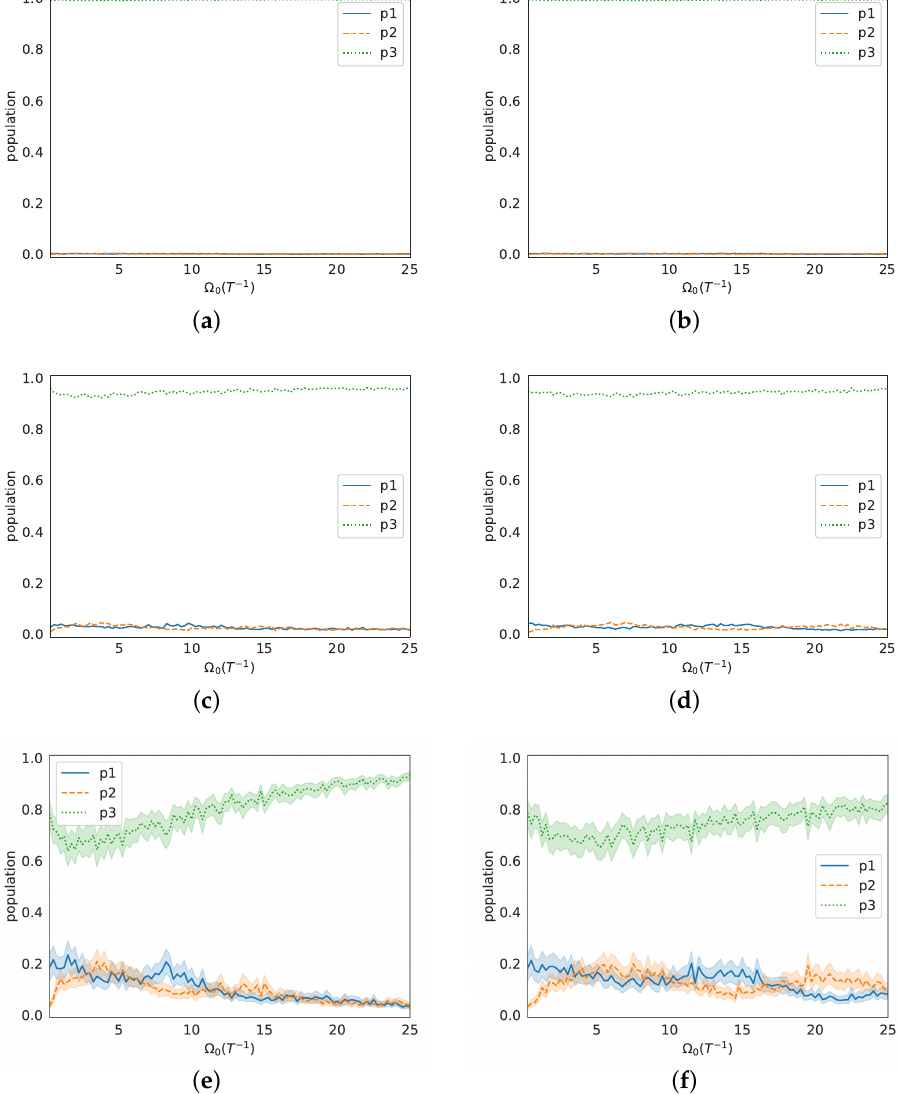
Figure 6. Final populations p i ( T ) , i = 1,2,3, as functions of parameter Ω 0 , for the STIRAP shortcuts derived from polynomial θ ( t ) with ( a , c , e ) constant Ω ( t ) = Ω 0 and ( b , d , f ) ramp Ω ( t ) = Ω 0 t / T . The three rows correspond to three different values of the noise correlation time, τ c / T = 0.008,0.08,0.8, respectively, while the standard deviation is set to σ n = 5 T − 1 . For the cases corresponding to τ c / T = 0.8 (last row), where the averages still fluctuate, we also display the 98% confidence